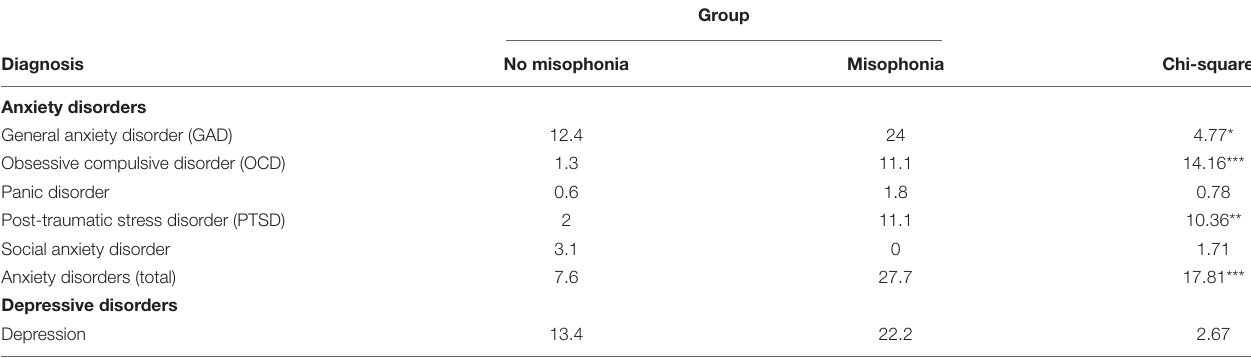
TABLE 10 | Percent self-reported diagnoses by